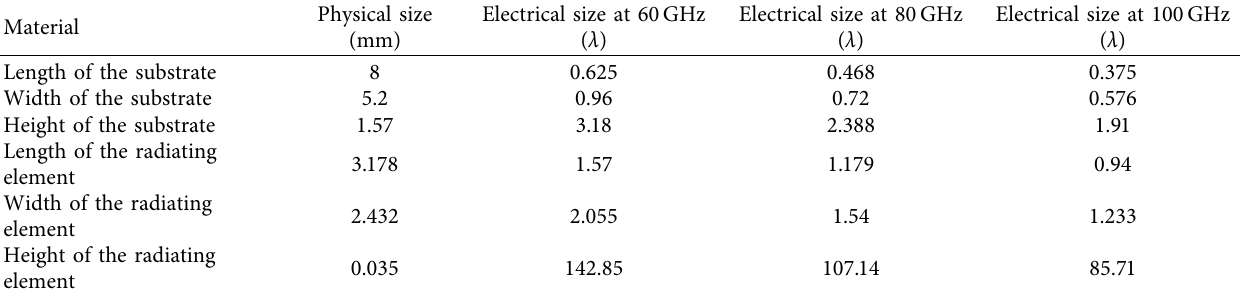
Table 1: Electrical size at different